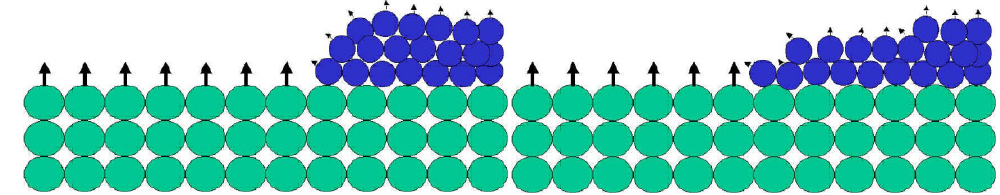
Figure 2. When a liquid with low surface energy ( blue spheres ) are placed on a solid surface with high surface energy, the blue spheres spread out and cover the green spheres